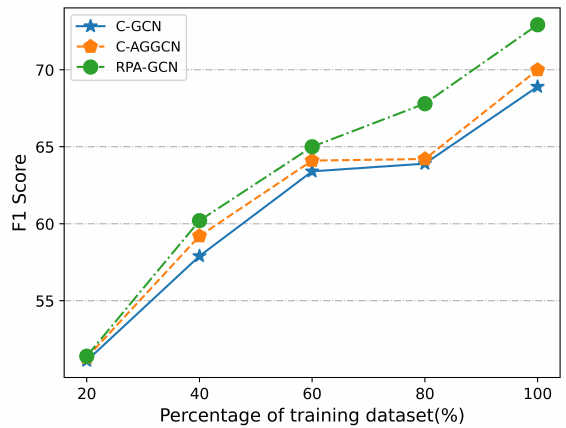
Figure 15. The effect of the number of trainings on F1.